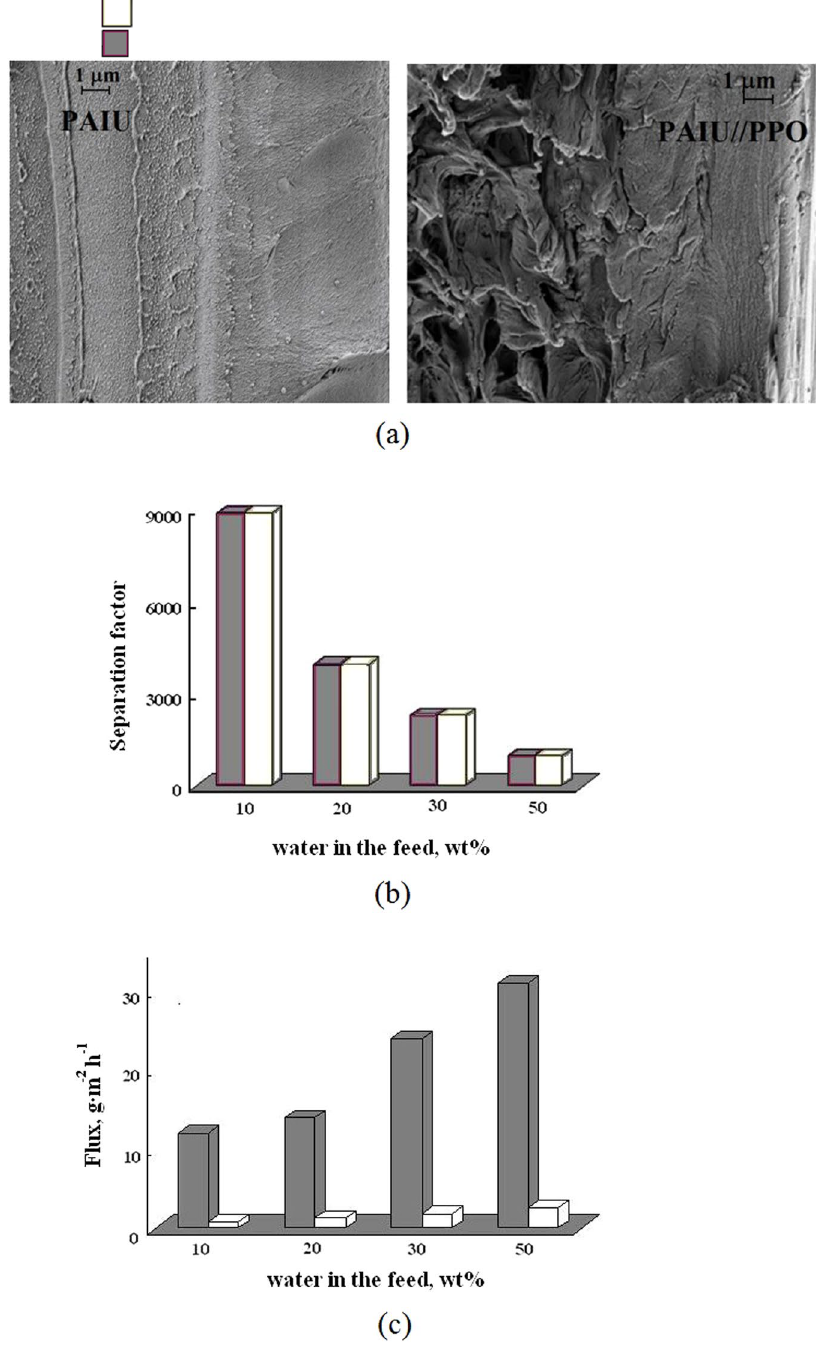
Figure 5. The SEM micrographs on cross-section of PAIU and PAIU/PPO films ( а ), the dependence of separation factor ( b ) and total flux ( c ) on the water content in the feed in pervaporation of water–isopropanol mixture using ( ) PAIU and ( ) PAIU/PPO